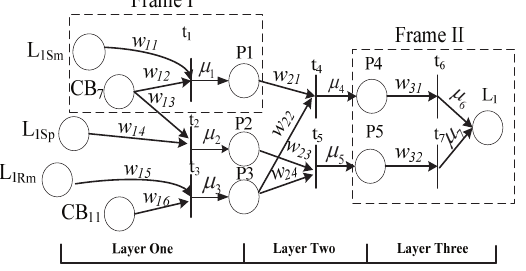
Fig. 1 The sub model of AFPN of power system fault diagnosis Fig.1 is a sub model of power system fault diagnosis base on AFPN, which was used for estimate whether line L1 in Fig.4 is faulty. Only main protective relays, receiving terminal breakers are included.